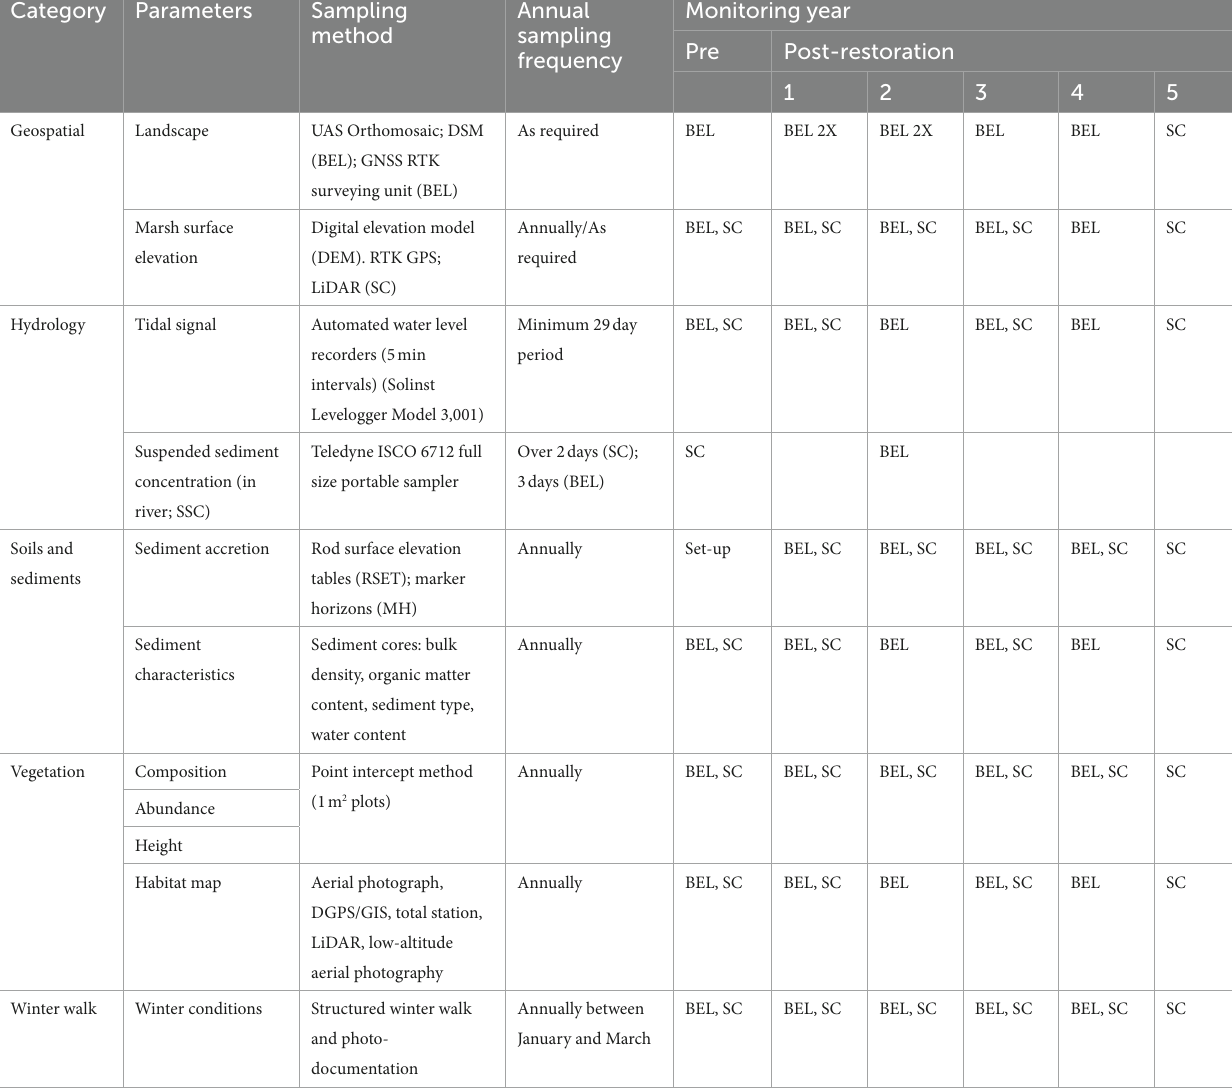
TABLE 2 Environmental sampling: Variables, including core and additional ecological indicators, methodologies, and frequency (sites: BEL: Belcher street; pre-restoration: 2017; post-restoration: year 1: 2010; year 5: 2014; SC: pre-restoration: 2007, 2008; post-restoration: year 1: 2018; year 4: 2021).